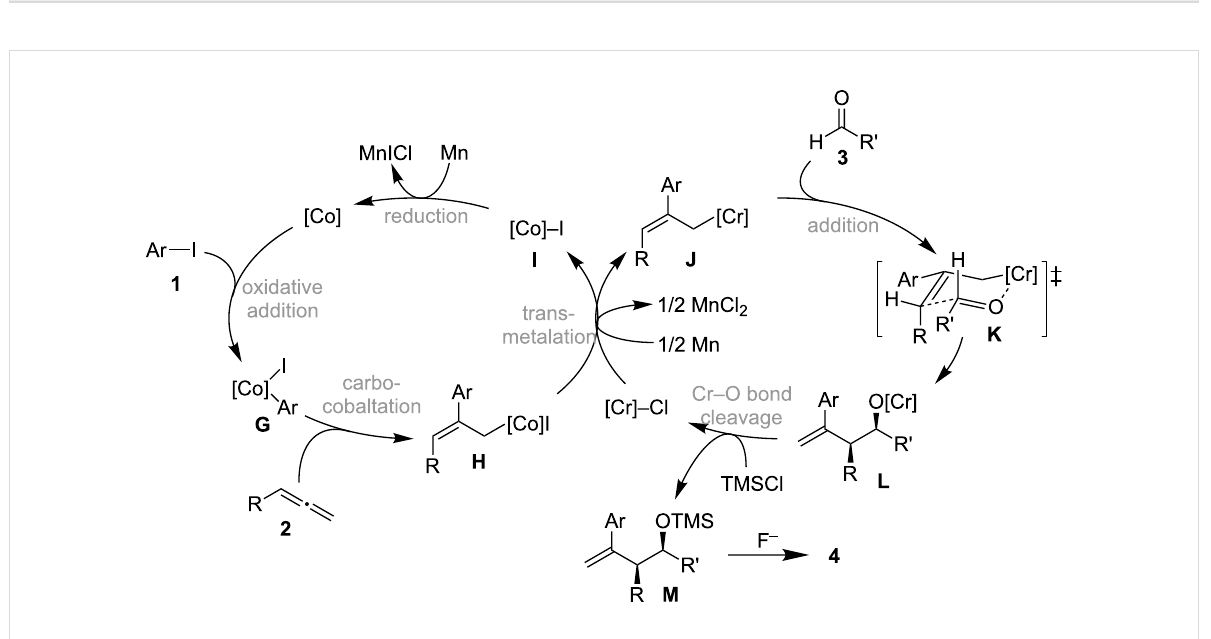
Scheme 12: Plausible reaction mechanism of the three-component